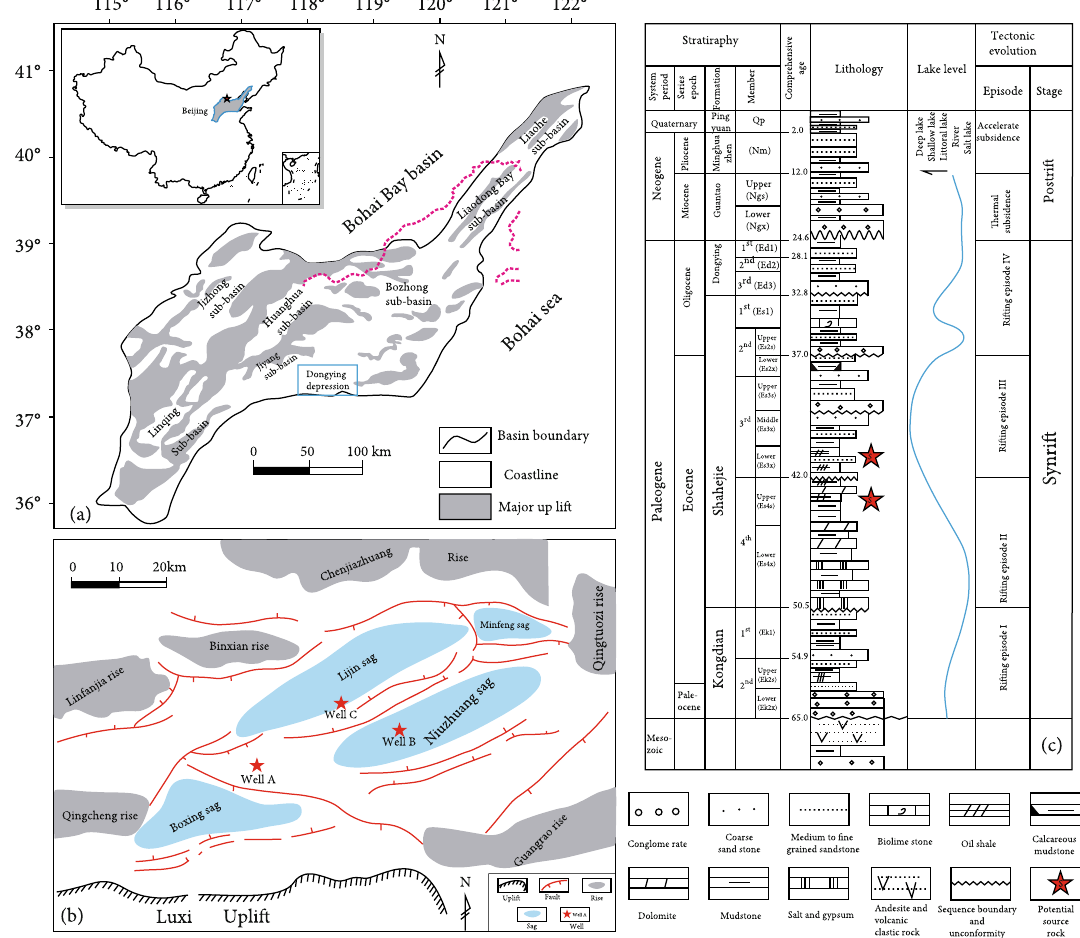
Figure 1: Location map of the study area. (a) Schematic map of the Bohai Bay Basin and its location in China. (b) Tectonic setting map of the Dongying Depression showing the uplift, sags, main faults, and shale oil well locations where the samples were obtained. (c) General stratigraphy column of the Dongying Depression (after Zhang et al.